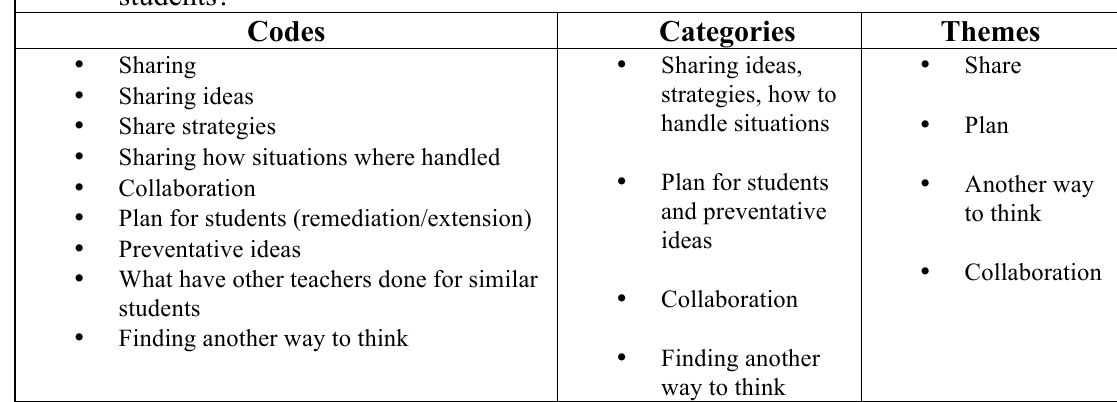
Teacher Question Eight and Codes 8. How do PLC meetings impact your ability to get through to the most